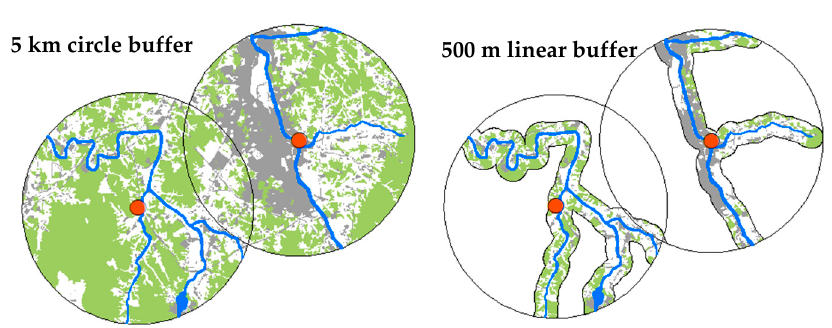
Figure 2. Circle buffer scale set to 5 km radius in the watershed and linear buffer set to 500 m in the riparian area near the sampling sites (green color; forest and grass areas, gray color; urbanization areas, blue color; streams, orange circle; sampling points).